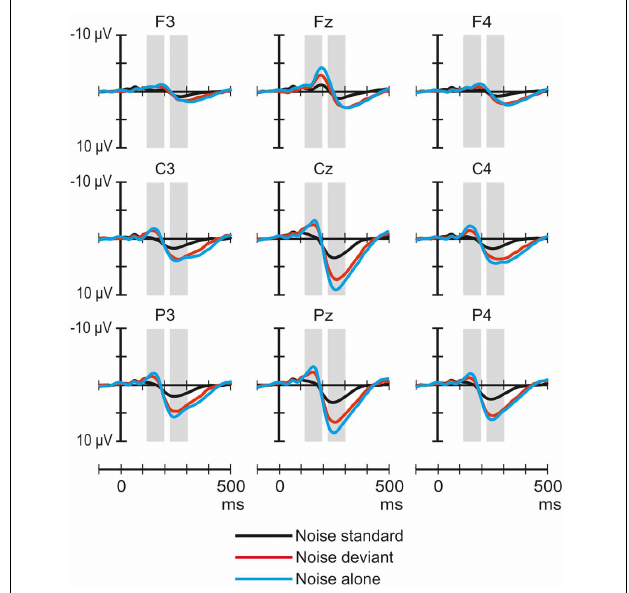
FIGURE 3 | Group-average ( n = 33) ERP responses elicited by the noise segments in the noise-deviant (red line), noise-standard (black), and noise-alone (blue) conditions at frontal, central, and parietal scalp locations. Amplitude measurement windows are indicated by gray